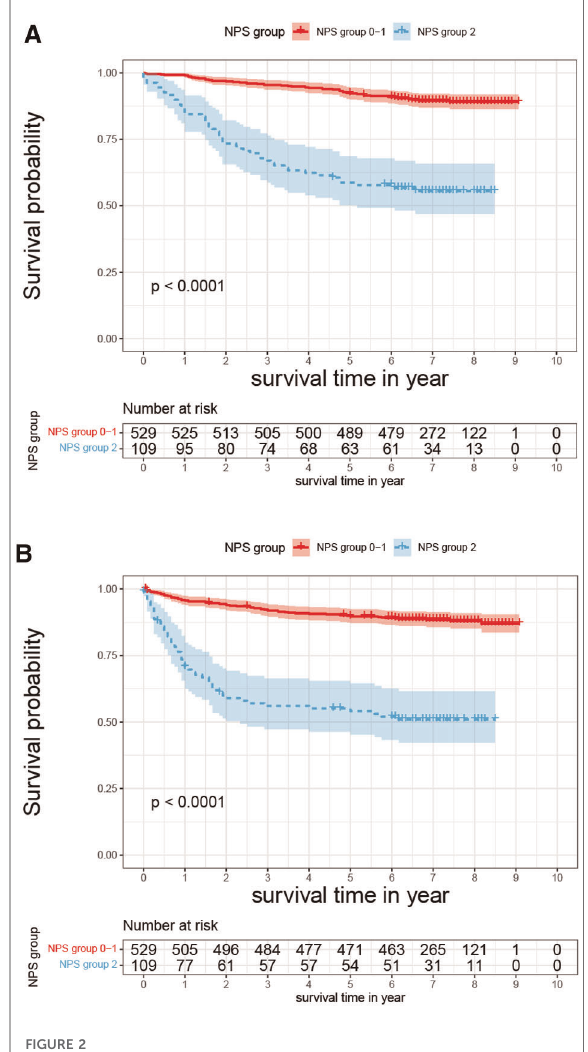
FIGURE 2 Kaplan – Meier curves of ( A ) overall survival and ( B ) progression-free survival for NPS groups 0 and 1 and group 2. NPS, Naples prognostic